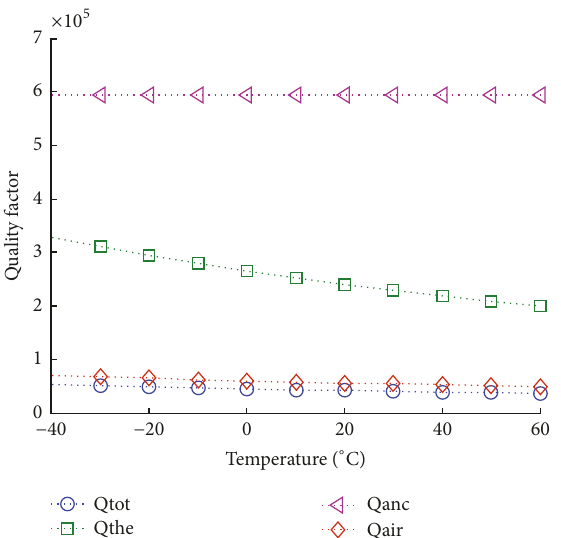
Figure 11: Quality factor Q of 10Pa.